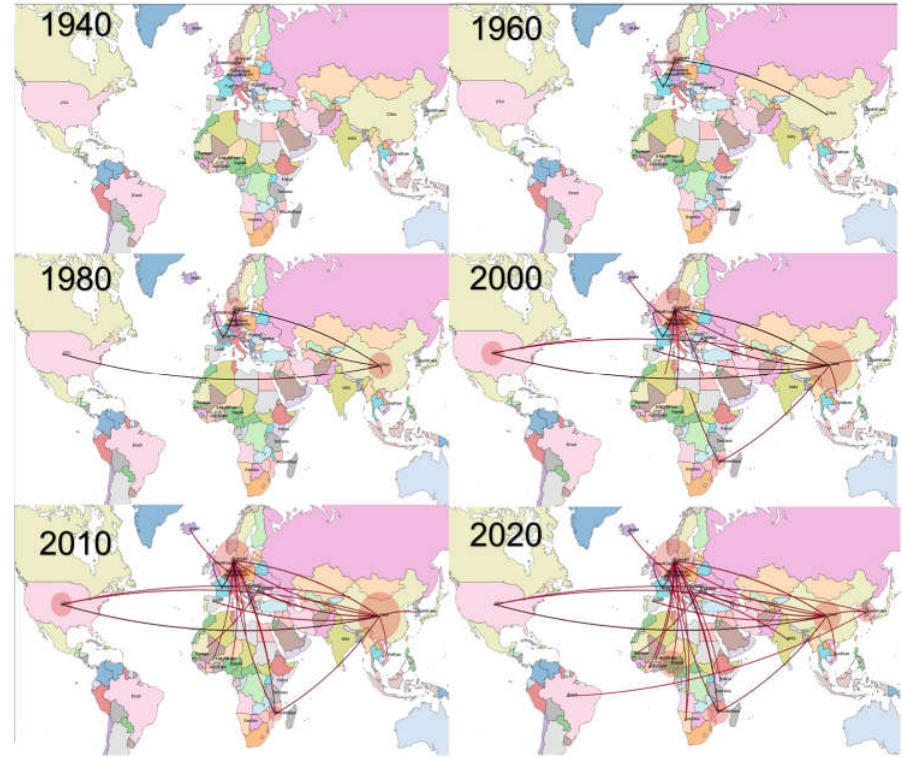
Figure 2. Phylogeographic reconstruction of PPV1 migration among countries over time. Each picture represents a different decade. The edges connecting the countries have been color-coded from black to red based on the estimated age .